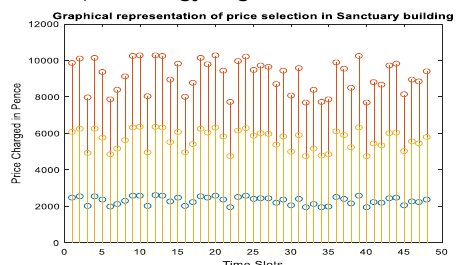
Figure 6. Maximum, minimum charged in